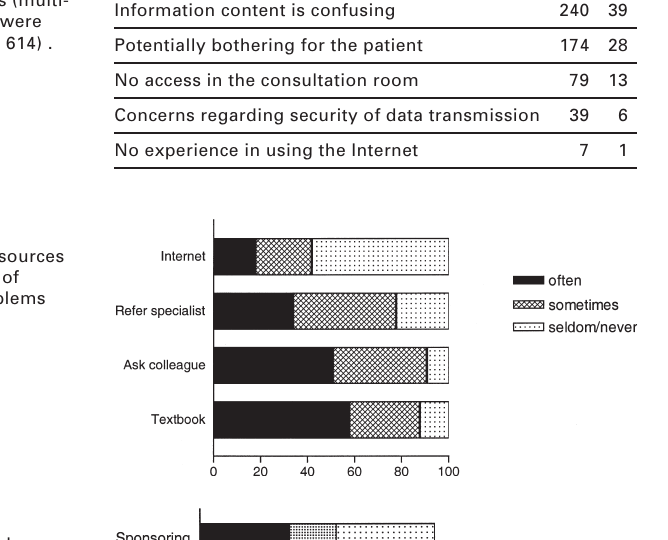
Criteria used by general practitioners for quality assess- ment of the informa- tion retrieved from the Internet (n =